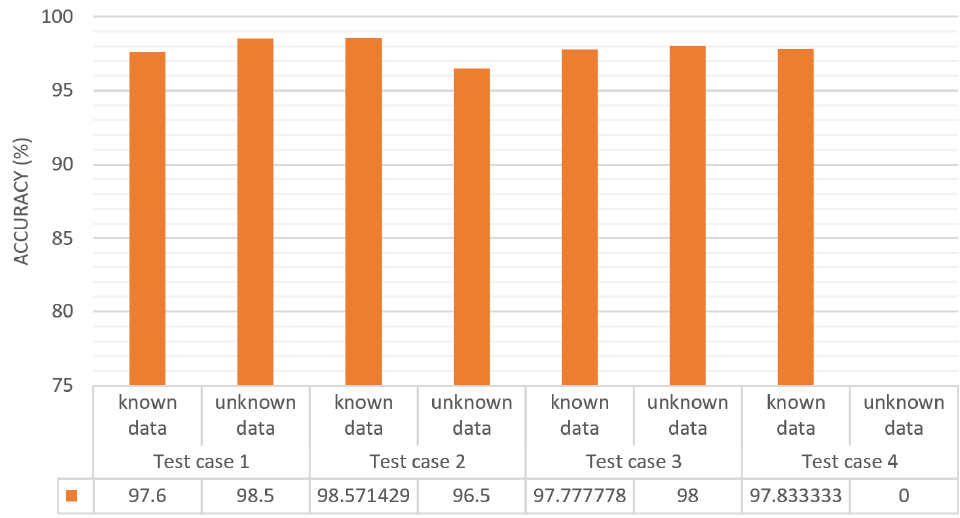
Figure 12. Classification accuracy for known and unknown data for each test case.